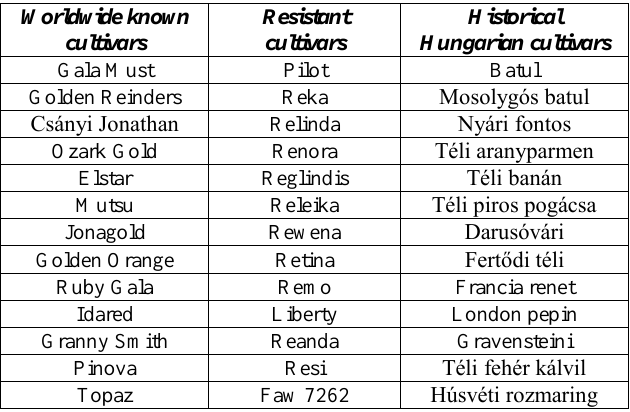
Table 1. Classification of the apple cultivars (Debrecen – Pallag,